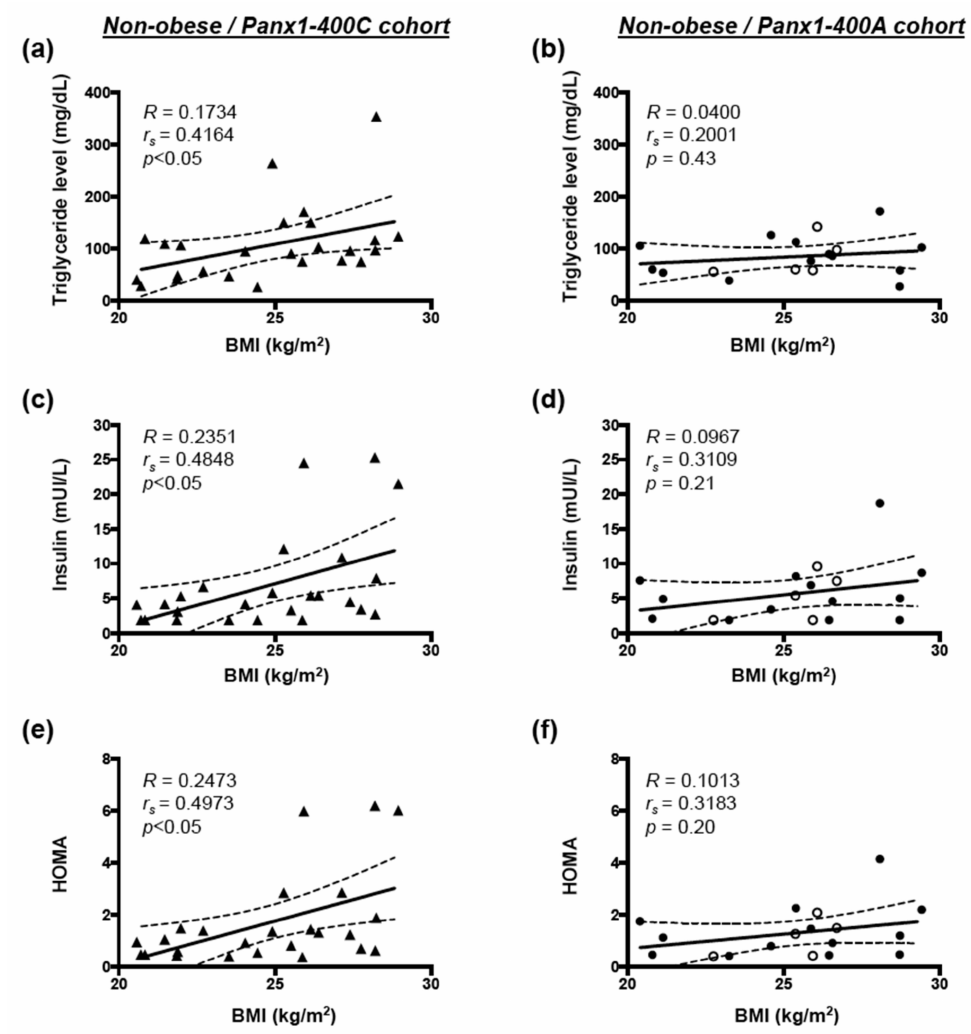
Figure 4. Correlation between BMI and cardiovascular risk factors in non-obese subjects. Spearman correlations in non-obese subjects between body mass index (BMI) and serum triglycerides ( a , b ), insulin ( c , d ) and HOMA ( e , f ) in the Panx1-400C cohort (( a , c , e ) n = 25) and the Panx1-400A cohort (( b , d , f ) n = 18). AA genotype: open circles; AC genotype: closed